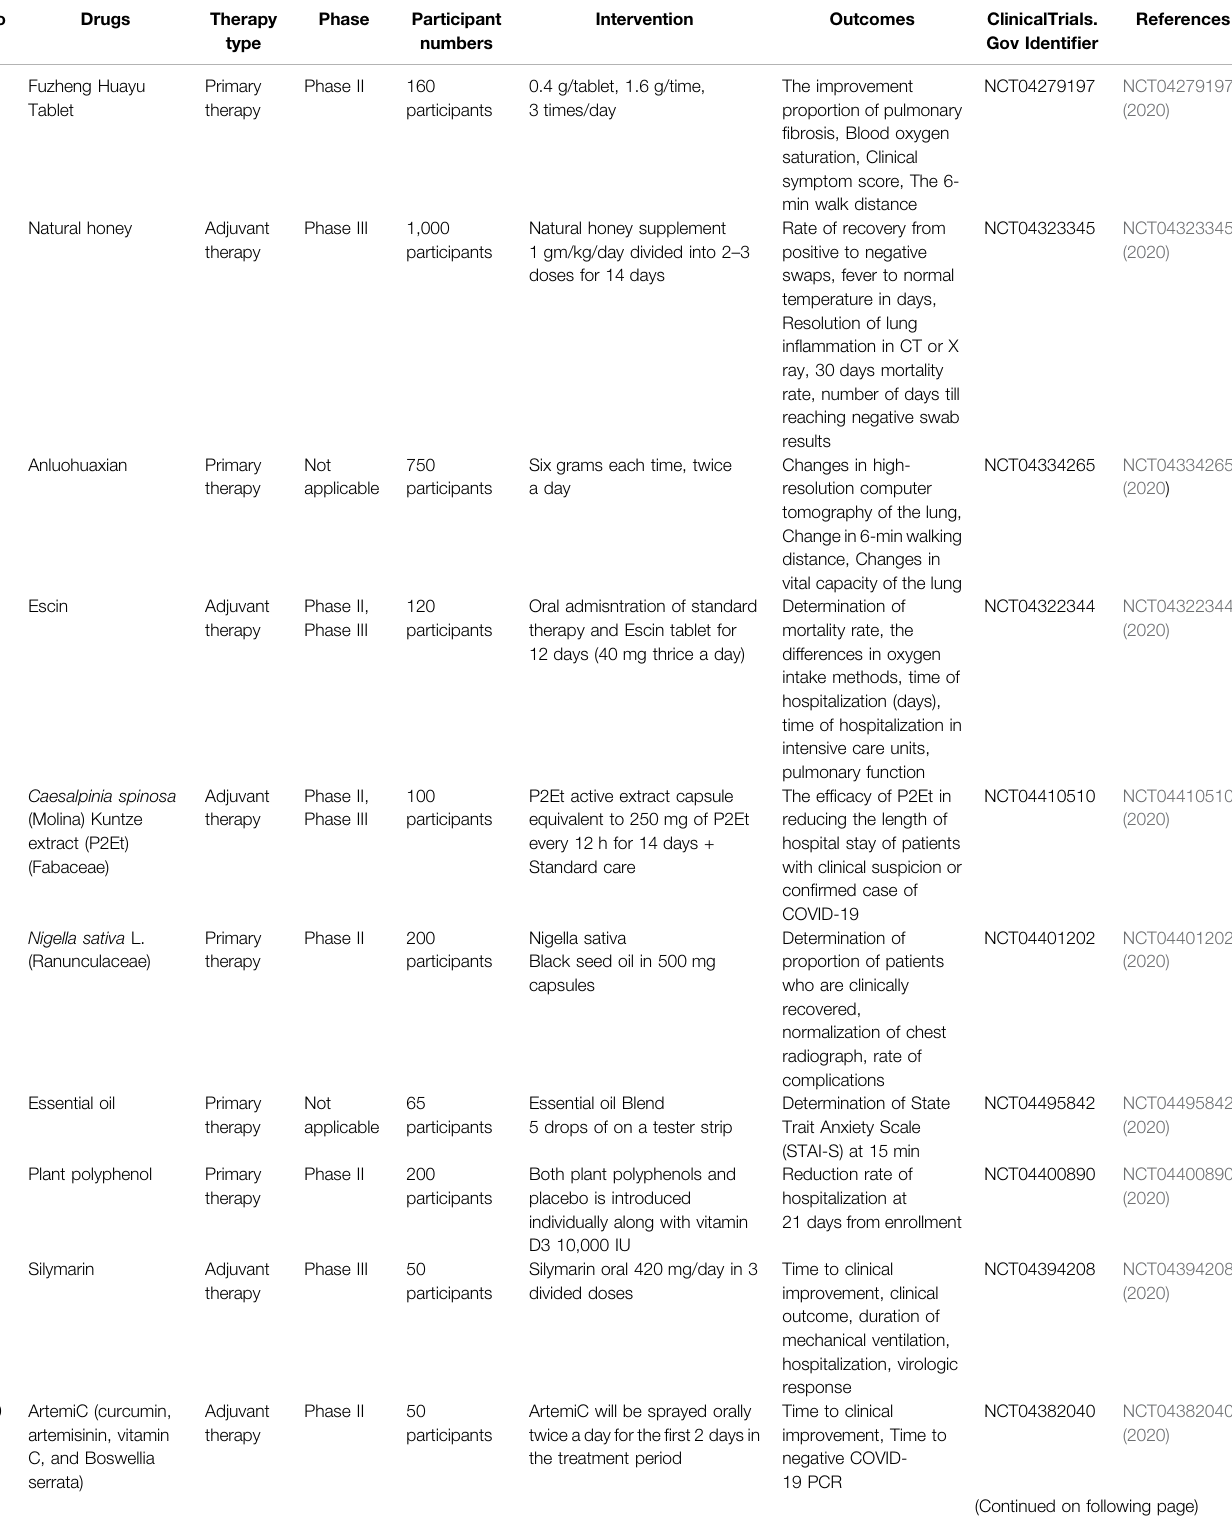
TABLE1| Ongoingclinicaltrialsofseveralplants,functionalfoods,andplantbasedproductsincludingbioactivephytocompounds,traditionalmedicines,nutraceuticalsand similar other preparations against SARS-CoV-2